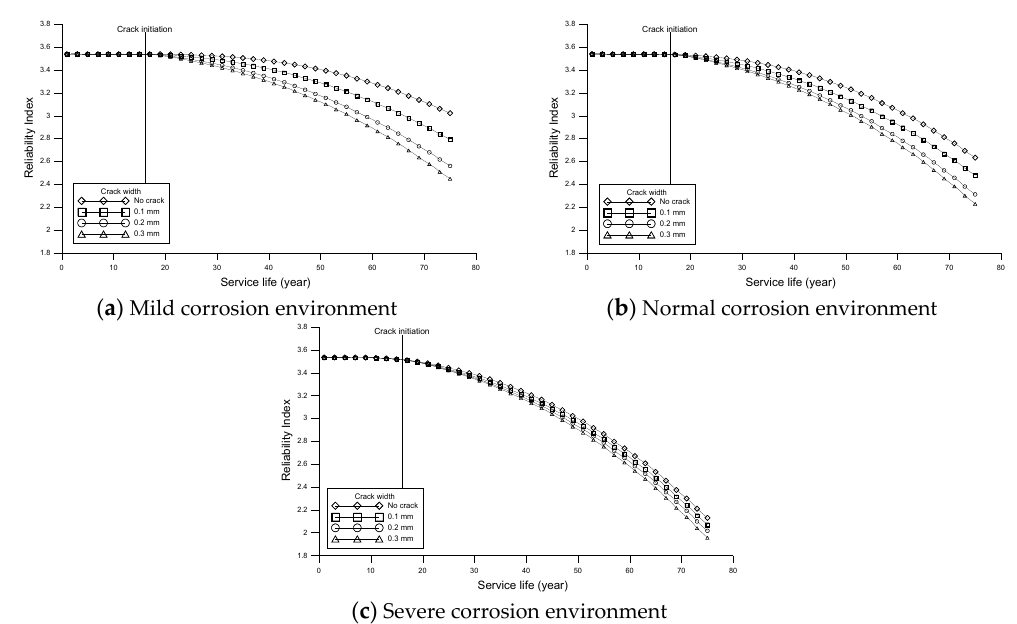
Figure 14. Reliability degradation considering crack width under light traffic characteristics (calibrated model (1-W)).